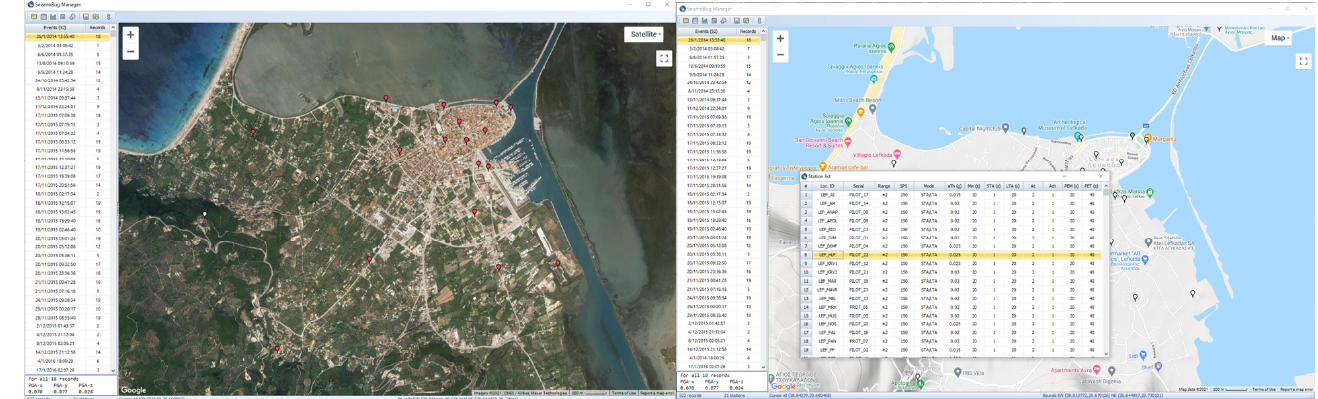
6 of 12 Figure 4. Device validation: ( a ) Seismic table test setup ( b ) Record comparison in time and frequency domain for a 5 Hz harmonic signal ( c ) PSD levels for a 60 s of ambient noise measurement. 3.2. SeismoBug © Browser The SeismoBug© Browser software was developed in the simple form of a “file ex- plorer” (Figure 5) for the assessment and postprocessing of the bulk of records collected from the installed devices. The user can quickly browse through the record list and view various information for each one, helpful for quick identification and assessment. Specif- ically, the program displays the time–acceleration, velocity and displacement histories for all three directions, their decomposition in the frequency domain (FFT), elastic response spectra and triggering parameters (e.g., STA/LTA). Furthermore, direct record resampling (Lanczos) can be applied, together with linear baseline correction and bandpass filtering. Figure 5. The SeismoBug © Browser software. 3.3. SeismoBug © Manager For the compilation of ground motion shakemaps after a successful recording of an earthquake, the bulk of collected records from the installed network are postprocessed using the SeismoBug © Manager GIS-based software (Figure 6). The installed unit locations are georeferenced on a digital map (Google Maps © ) and all concurrent records (within a